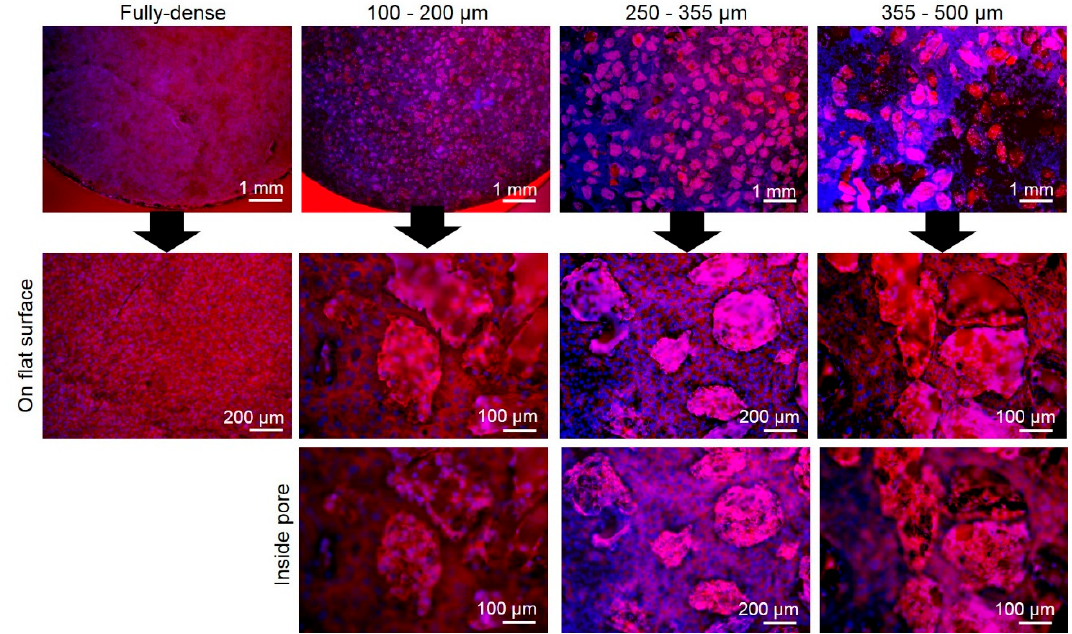
Figure 9. Immunofluorescence images of cell actin cytoskeleton (in red) and cell nuclei (in blue) of preosteoblast MC3T3 growing for 10 days. Medium and lower images correspond to higher magnification of areas focusing in same area on flat and inside pores of the studied specimens. Bottom images show the cells attached inside pores and medium the same cells well focused on flat areas.